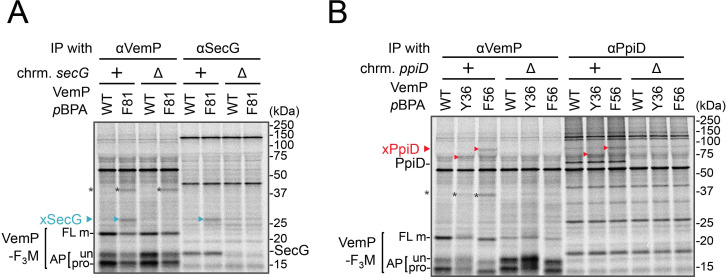
Identification of VemP crosslinked products.(A) VemPxSecG XLs. (B) VemPxPpiD XLs. The cells of the indicated strains were grown, induced to express a VemP-F3M derivative with pBPA at the indicated position (WT indicates the protein with no pBPA), pulse-chased, and UV irradiated as in Figure 1. Labeled proteins were subjected to IP with indicated antibodies and analyzed as in Figure 1. The result shown is a representative of two technical replicates. Asterisks in A and B represent crosslinked dimer forms of VemP-F3M.